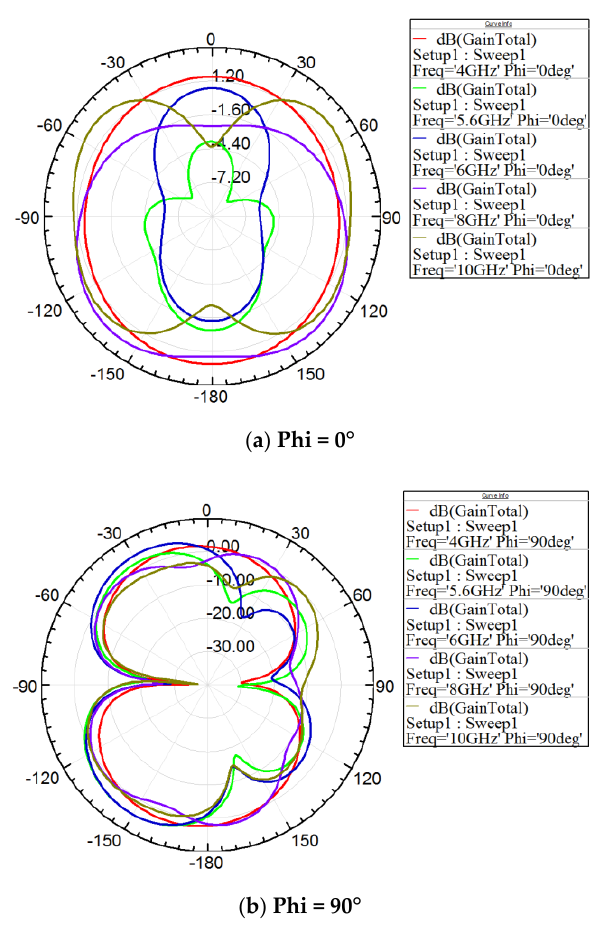
Figure 42. Radiation pattern for 2 × 4 array, ( a ) Phi = 0 ◦ ( b ) Phi = 90 ◦ .